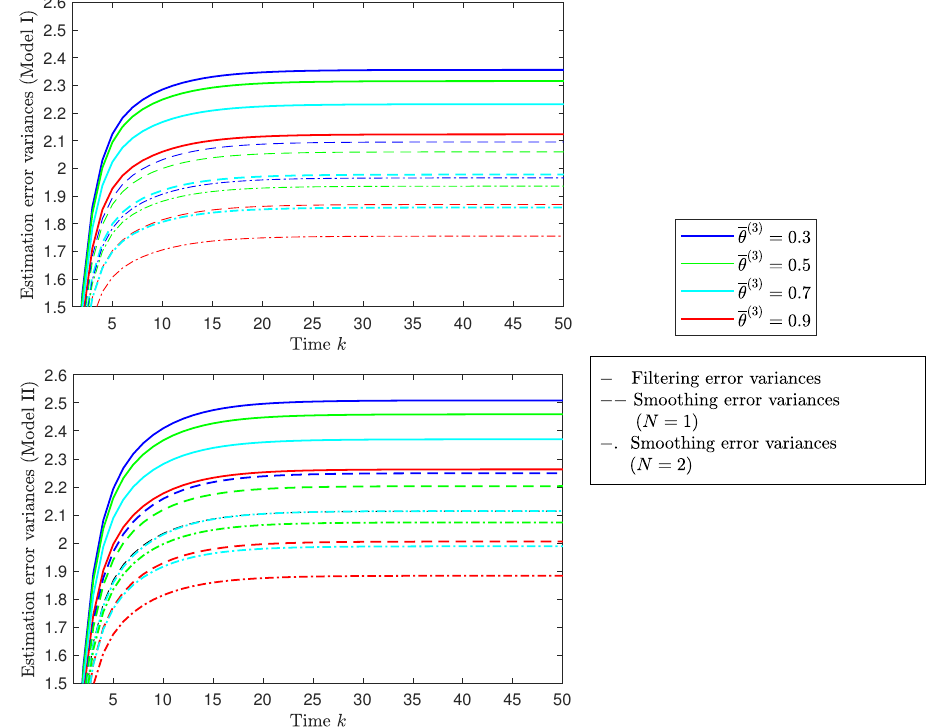
( 3 ) = 0.3,0.5,0.7,0.9 under